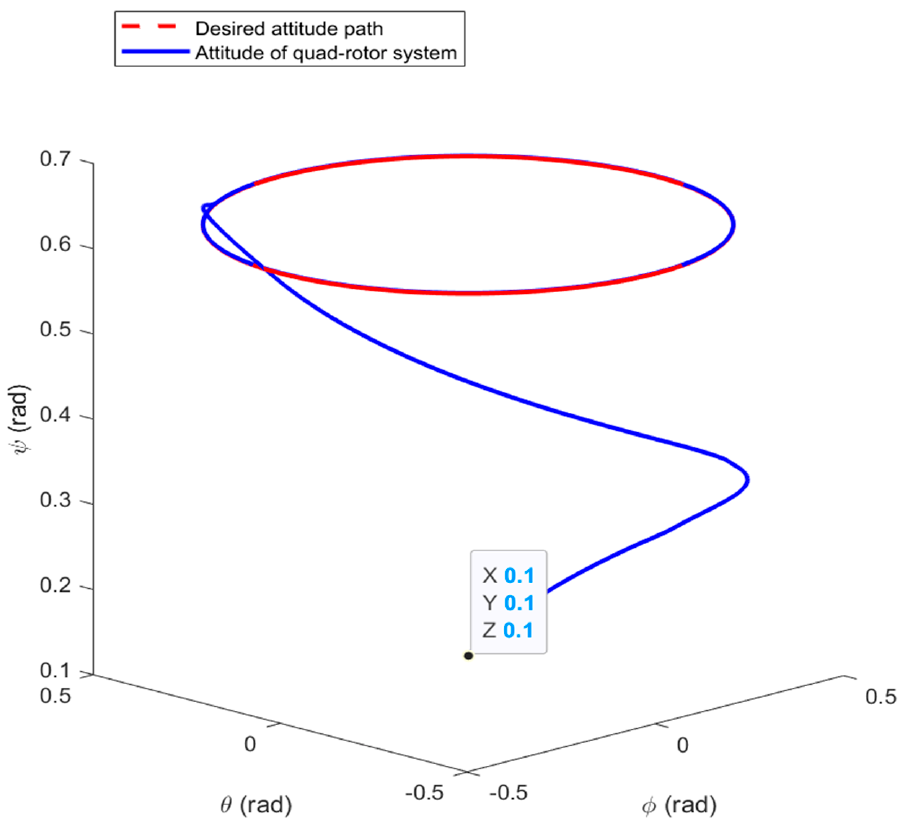
Figure 2. 3-D attitude tracking of the quadrotor system.